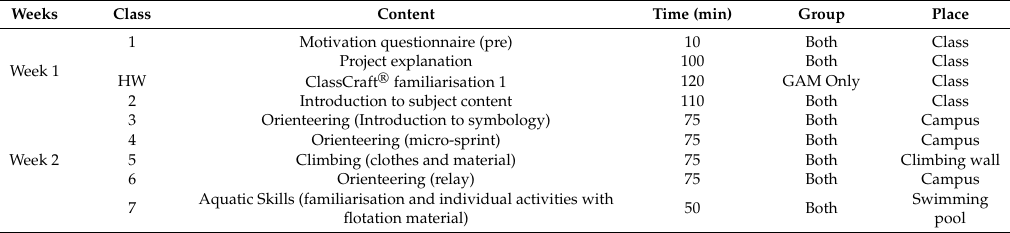
Table 2. Research design